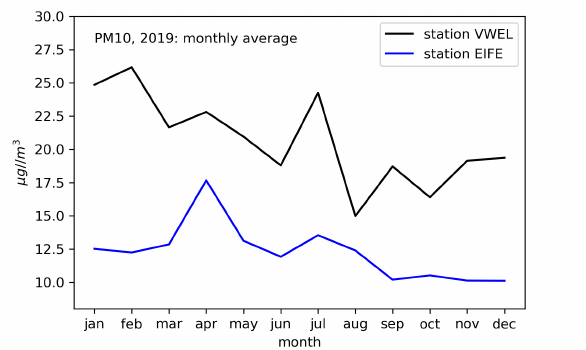
Figure 2. Monthly average values of PM 10 (year 2019) for the urban station VWEL and the rural station EIFE.